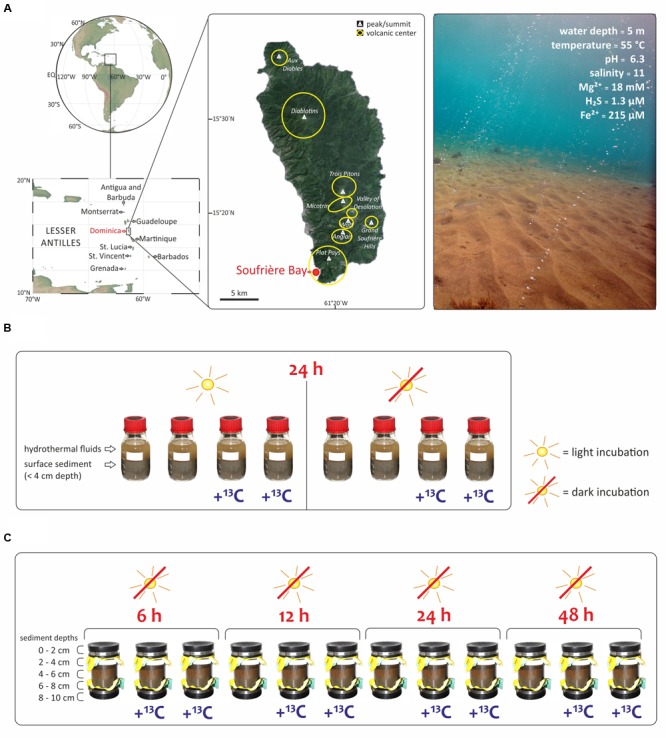
Study area and experimental set up of this study. (A) The shallow hydrothermal system is located in Soufrière Bay in the southwest of Dominica (Lesser Antilles) adapted from Gomez-Saez et al. (2015). Maps were created using Ocean Data View (R. Schlitzer, http://odv.awi.de) and Google Earth (http://earth.google.com). Submarine photo courtesy of A. Madisetti showing light reaching the surface sediment at 5 m water depth and visible orange color due to Fe3+ oxides precipitates. Geochemistry values taken from Gomez-Saez et al. (2015, 2016). (B) SIP-experiment to evaluate the effect of light with incubations under light and dark conditions. Bottles of 250 mL were filled with hydrothermal fluids and surface sediment (<4 cm depth) and incubated during 24 h. (C) SIP-experiment to investigate different redox interfaces under dark conditions as a function of incubation time (6 to 48 h) and sediment depth at five intervals (0–2, 2–4, 4–6, 6–8, and 8–10 cm). All samples in (B,C) were incubated at 55°C, corresponding to the in situ temperature of the hydrothermal fluids at the sampling site.